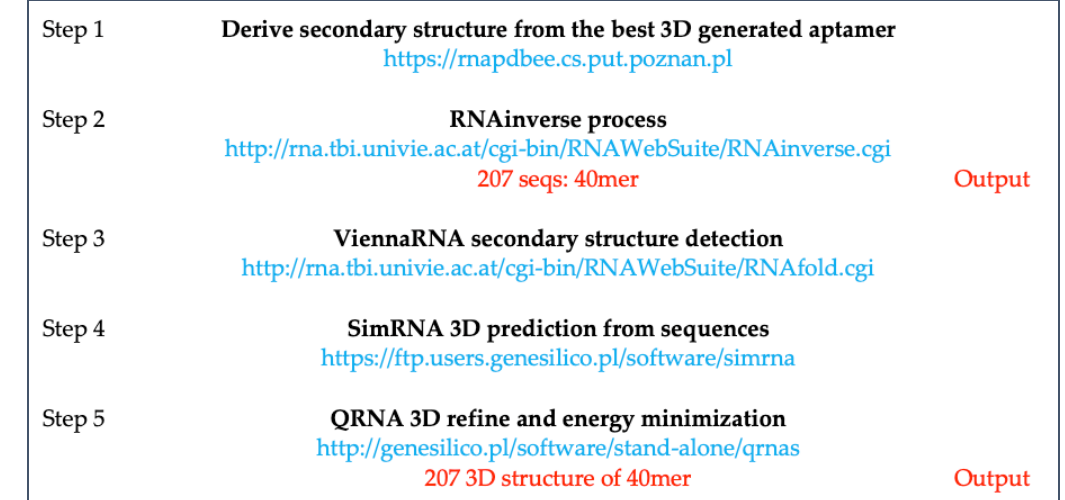
Figure 12. Schematic representation of the workflow.